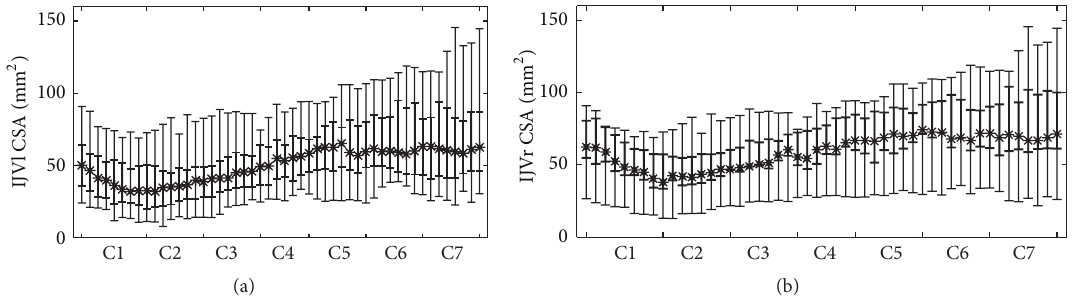
Figure 2: Descriptive statistics of IJVl CSA (a) and IJVr CSA (b) displayed along C1 and C7 cervical levels. The median (asterisks), the 5th–95th percentiles (bars), and the 25th–75th percentiles (bold bars) are represented.